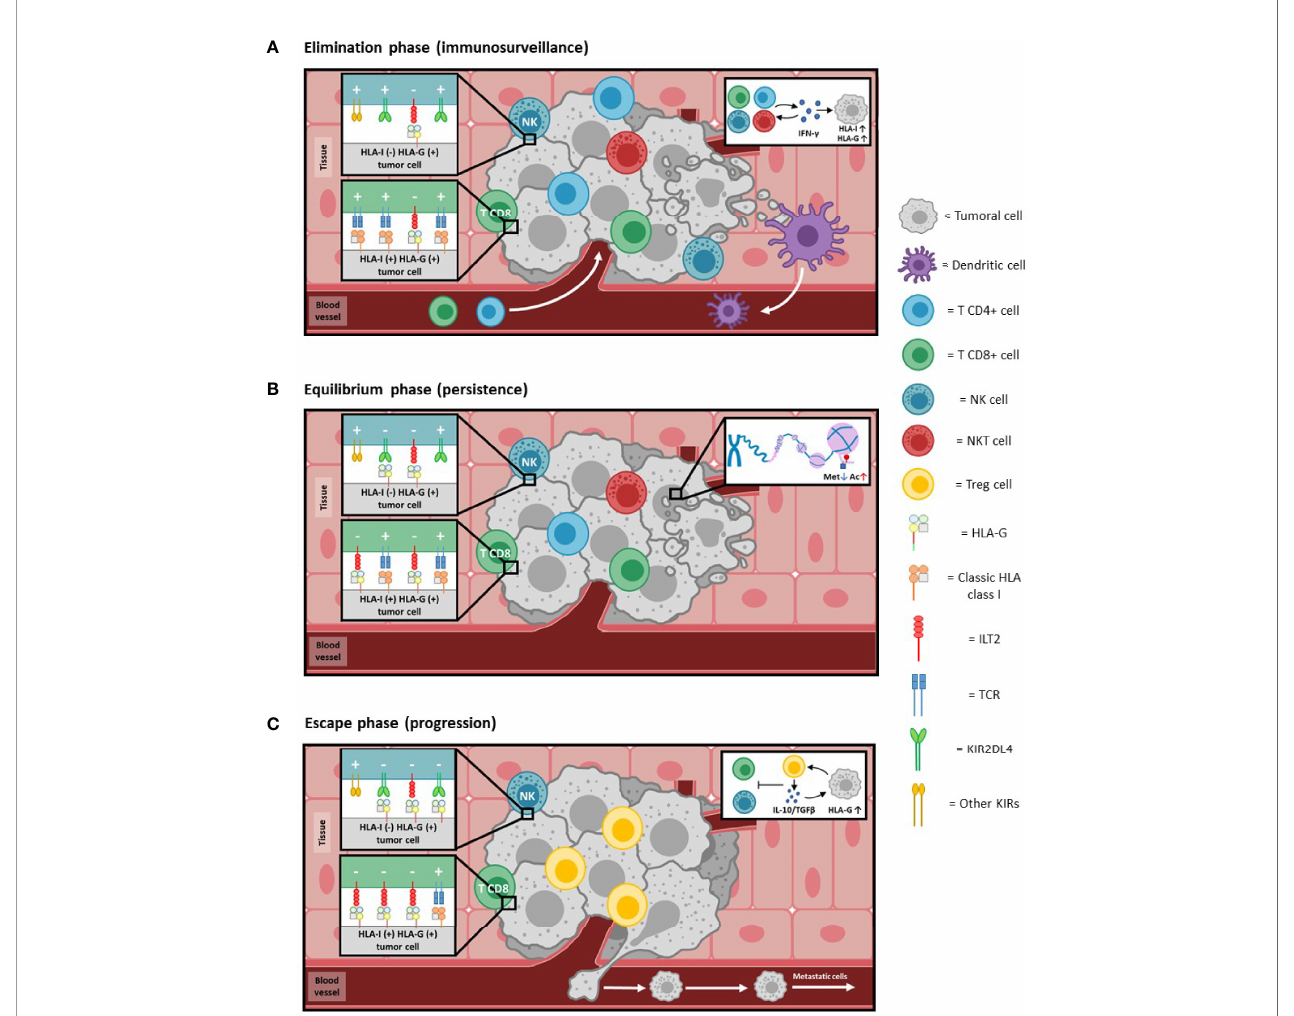
FIGURE 4 | HLA-G and cancer immunoediting. Immunoediting of cancer, a phenomenon whereby cancer and immunocompetent cells interplay, leading in some instances to tumor overgrowth. Consists of three phases (see references 63-66 for details): (A) Elimination phase: In reply to the neoplastic process, immunocompetent cells extravasate and in fi ltrate the tumoral tissue. The combined action of both innate and adaptive immunity effectors detects and kills malignant cells. The production of cytokines, such as IFN g (see insert 4A), induces an increase in the expression of HLA class I molecules. Cells that present tumor antigens through HLA class I molecules [HLA-I (+)] are targeted mainly by CD8+ T lymphocytes. Those that do not present class I molecules on their surface [HLA-I (-)] are eliminated by NK cells. The expression of HLA-G can also be induced [HLA-G (+)] by IFN g , although to such low levels compared to HLA class I that its inhibitory activity (-) is negligible compared to the activating (+) capacity, and thus the tumor is controlled by the immune system. (B) Equilibrium phase: As adaptive immunity continues to eliminate tumor cells, it simultaneously exerts selective pressure leading to the generation of less immunogenic malignant cells (e.g., selective or complete loss of HLA class I molecules and/or tumor antigens). Genetic instability resulting from defective intracellular control mechanisms, as well as frequent epigenetic changes, further contribute to the development of a non-immunogenic phenotype. Histone demethylation and acetylation processes (insert 4B) lead to epigenetic activation of HLA-G, allowing its expression to increase to levels comparable to the HLA class I molecules present at that time. Activation (+) and inhibition (-) signals will be balanced, leading to an equilibrium process in which the immune system becomes progressively less able to eliminate the tumor. (C) Escape phase: Tumor cells that have lost molecules relevant for immune recognition [HLA-I (-)] now tend to express higher levels of HLA-G on their surface [HLA-G (+)]. HLA-G creates peripheral tolerance by inducing anergy, immunosuppressive cells (Treg) and production of immunosuppressive cytokines (IL-10 and TGF b ; insert 4C). In addition to the local effects of membrane-bound HLA-G, secreted soluble HLA-G could also have systemic inhibitory activity due to its distribution through the blood circulation. Inhibiting signals (-) overcome activating (+) ones in immunocompetent cells. Taken together, this allows complete escape by the tumor from the action of the immune system, which favors its development and processes such as